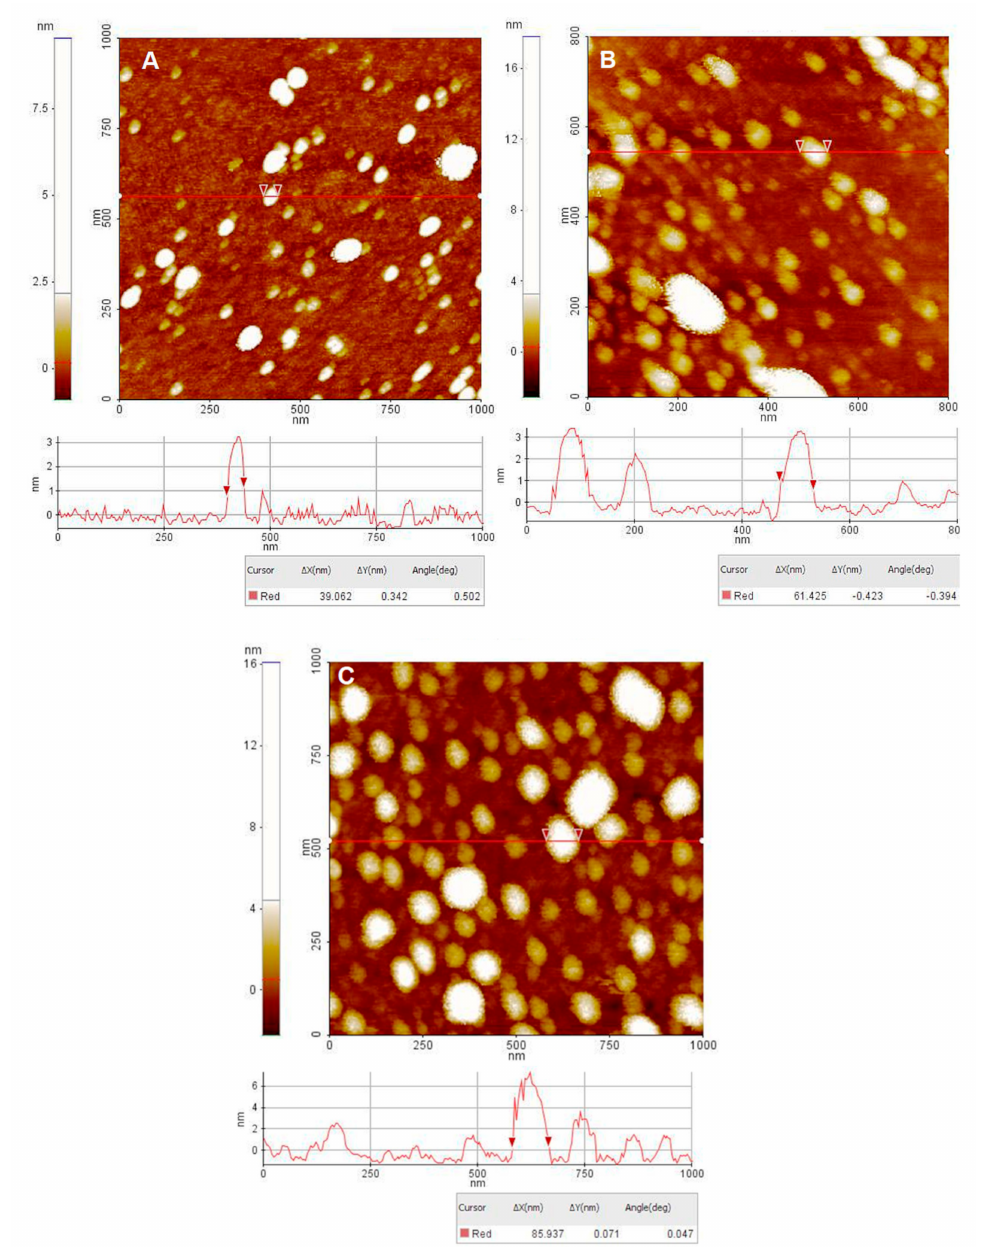
Figure 2. 2D AFM images together with representative line scans (surface profile) of the imaged samples: ( A ) liposomes, ( B ) transferosomes and ( C )